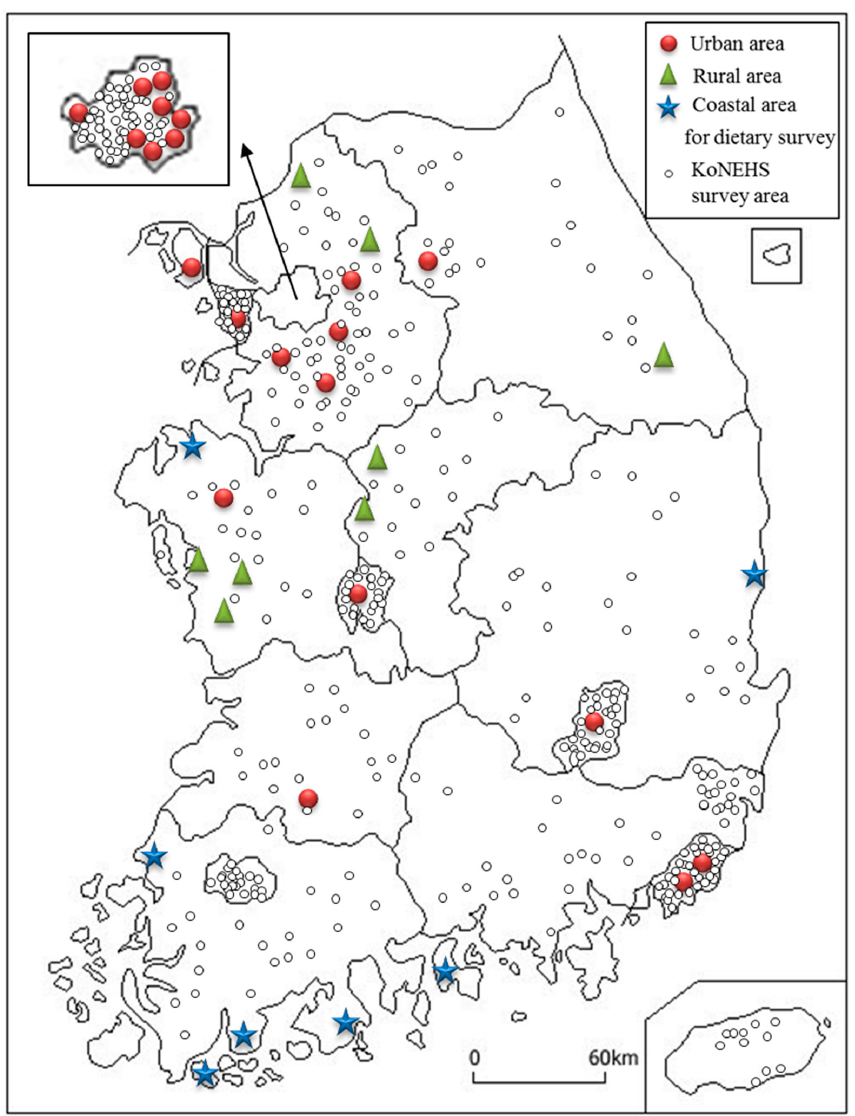
Figure 1. The geographic location of the pilot study area. Red circles, green triangles, and blue stars represent urban, rural, and coastal areas, respectively. Black open circles represent the total Korean National Environmental Health Survey (KoNEHS) target areas.